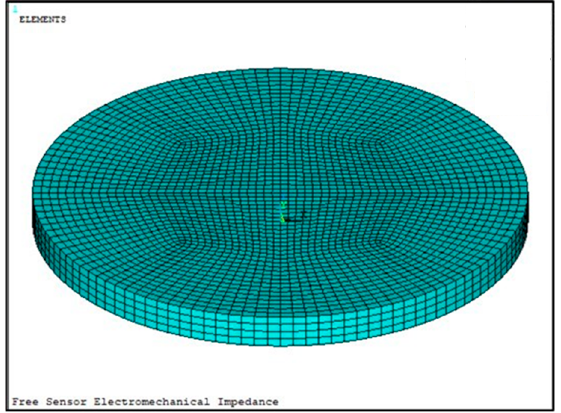
Figure 2. Sensor disk analytical model.